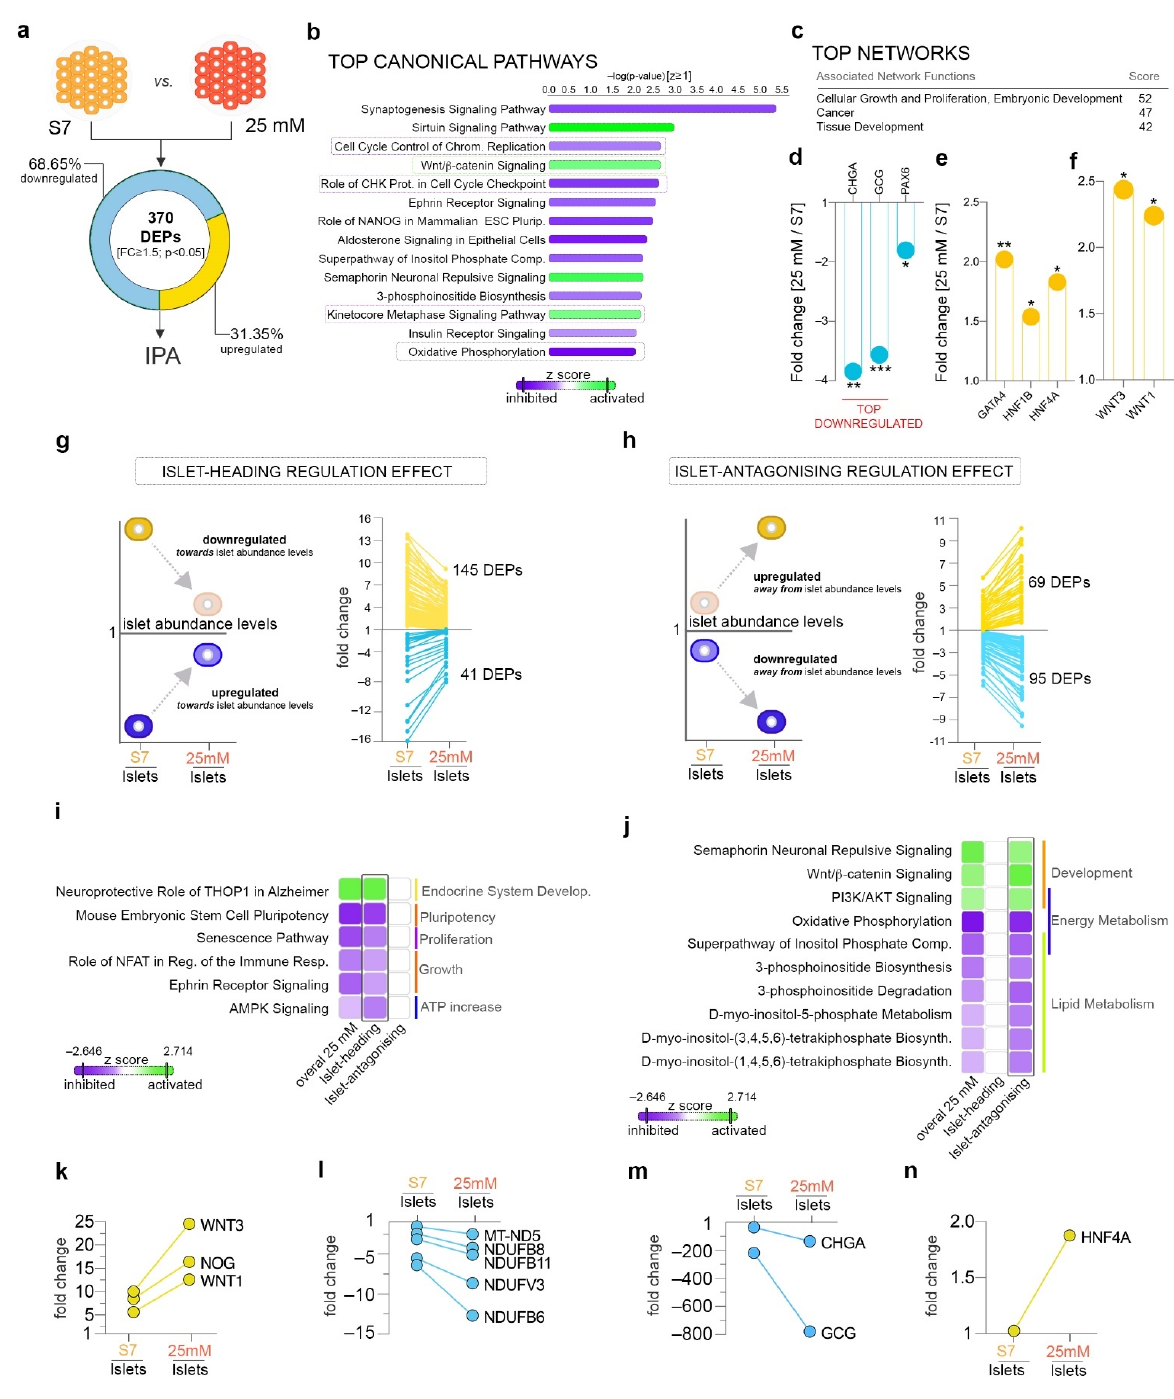
Figure 2. Pathway analysis of 25 mM glucose concentration effect. ( a ) Analysis workflow depicting the comparison employed. ( b ) Top canonical pathways with predicted regulation and ( c ) top networks characterizing the 25 mM glucose condition. ( d ) Selected dysregulated islet markers. ( e ) Selected differentially expressed developmental markers of pancreas development. ( f ) Graph of the observed downregulated WNT1 and WNT3 ligands in 25 mM glucose condition. ( g ) Scheme depicting the selection strategy and number of proteins displaying a dynamic of regulations compatible with an islet-heading or ( h ) an islet-antagonizing regulatory pattern in response to 25 mM glucose. Arrows represent the generic mandatory direction of regulation for inclusion in each respective subgroup. ( i , j ) Ingenuity Pathway Analysis (IPA)-generated comparison analysis of the protein landscapes characterizing the overall 25 mM effect, islet-heading and islet-antagonizing regulatory subgroups. ( k – n ) Graphs showing representative markers following an islet-antagonizing regulation. * p < 0.05, ** p < 0.01, *** p <